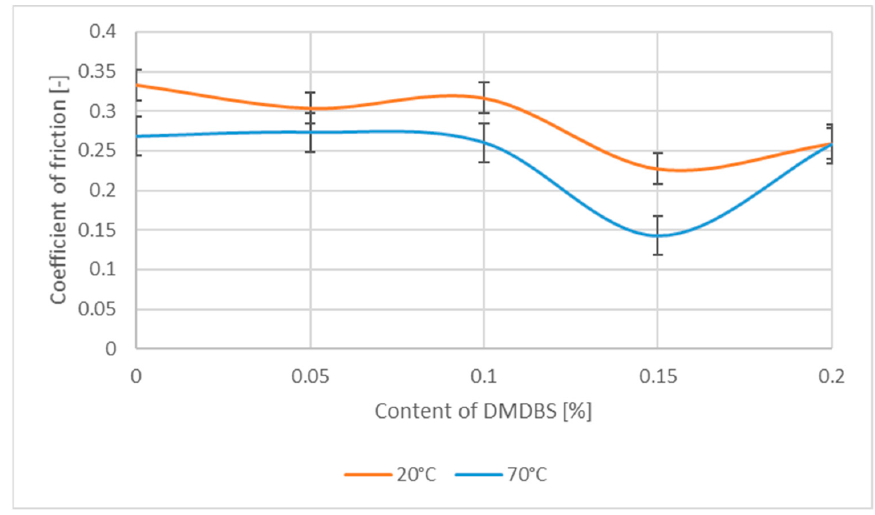
Figure 7. The coefficient of friction as a function of the DMDBS contain in the PP samples.